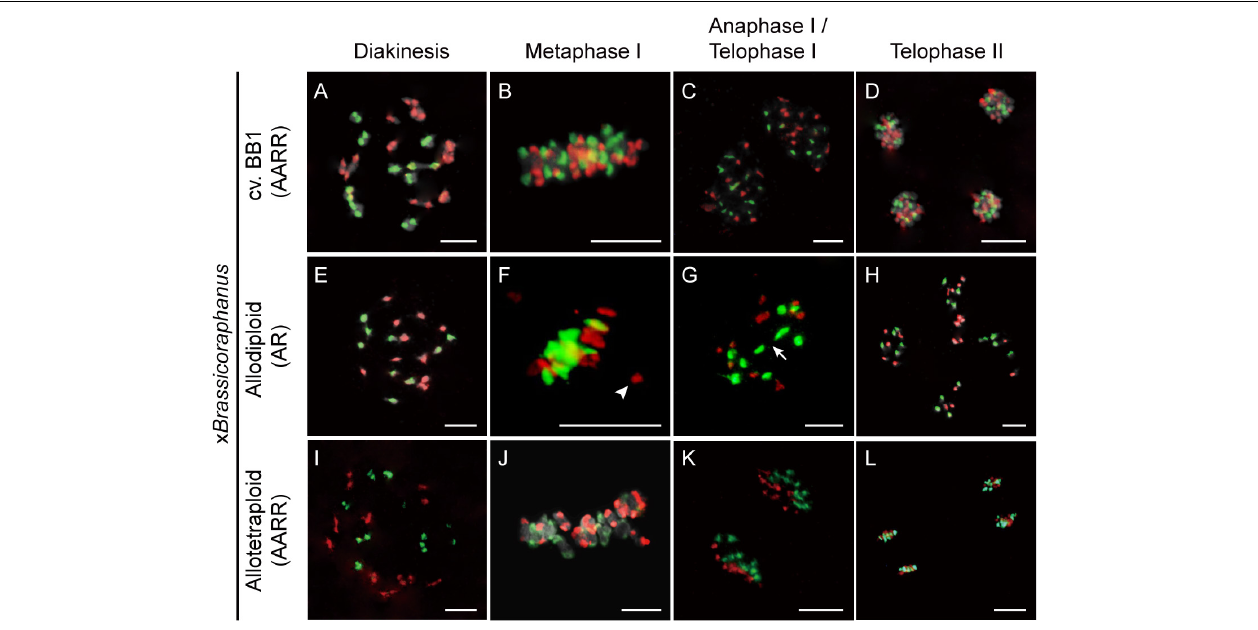
FIGURE 3 | Chromosome identification of x Brassicoraphanus by GISH analysis. Distribution of A and R chromosomes were observed in PMCs of BB1 (A–D) , and synthetic allodiploid (E–H) and allotetraploid x Brassicoraphanus (I–L) . Nineteen complete bivalents comprising ten from B. rapa and nine from R. sativus were shown in BB1 and allotetraploid x Brassicoraphanus , and homoeologous interactions between A and R chromosomes were scantily detected in allodiploid x Brassicoraphanus . The A and R chromosomes are stained in red and green, respectively. Arrow indicates the position of chromosome bridge formed between R chromosomes ( Supplementary Figure 3 ). Arrowhead indicates an isolated chromosome. Scale bars = 10 µ